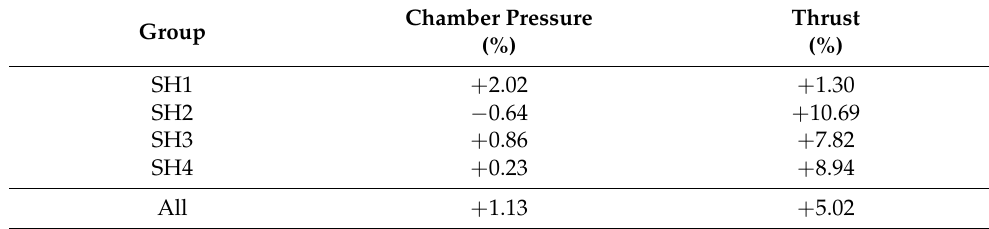
Table 7. Average deviation of numerical values from experimental measurements.